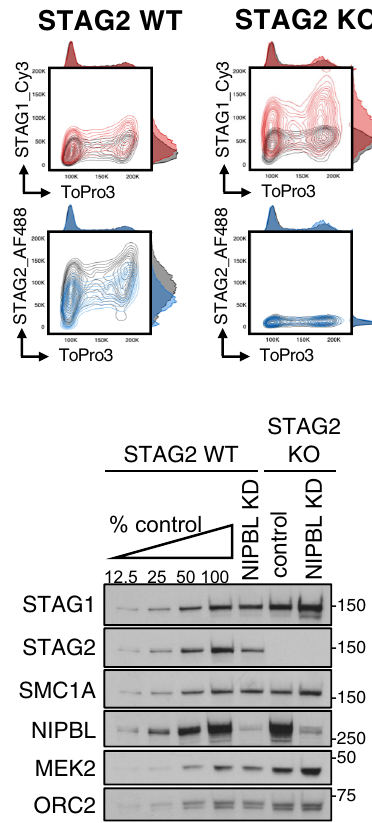
condition. Bottom, immunoblot analyses of the same cells. b As in a , for A673 cells with (WT) or without (KO) STAG2. All experiments were performed three times with similar